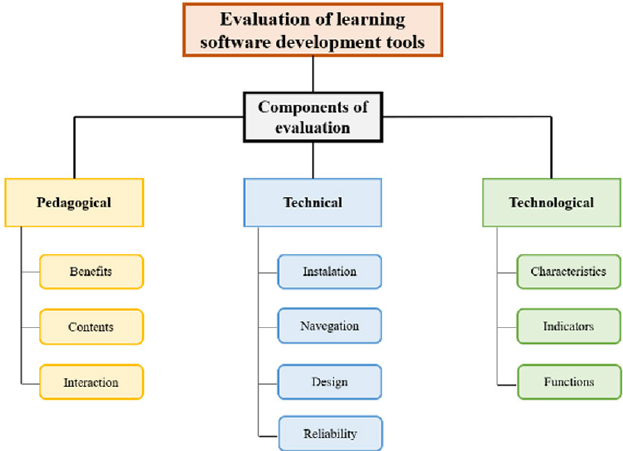
Fig. 11. Proposed model of evaluation of tools for developing educational